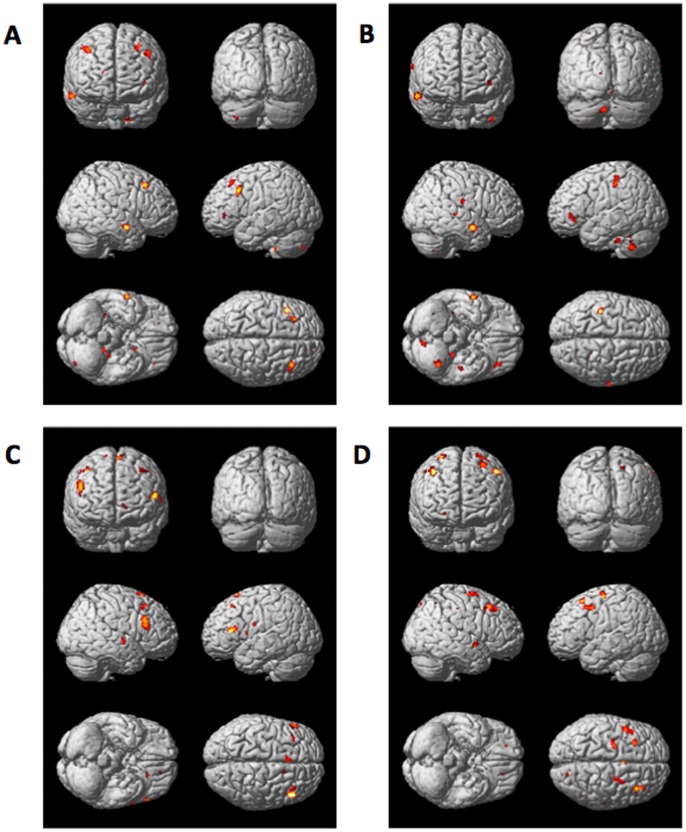
Functional connectivity patterns in ADHD. Brain areas in which activity is more tightly coupled with activity in the source area (A = left occipital, B = right cerebellum, C = inferior parietal, D = right caudate nucleus) in the working memory (N2) than the control (N0) condition, and more so in ADHD than Control children.Functionally connected regions are displayed at punc <0.001, superimposed on the ICBM standardized anatomical template.